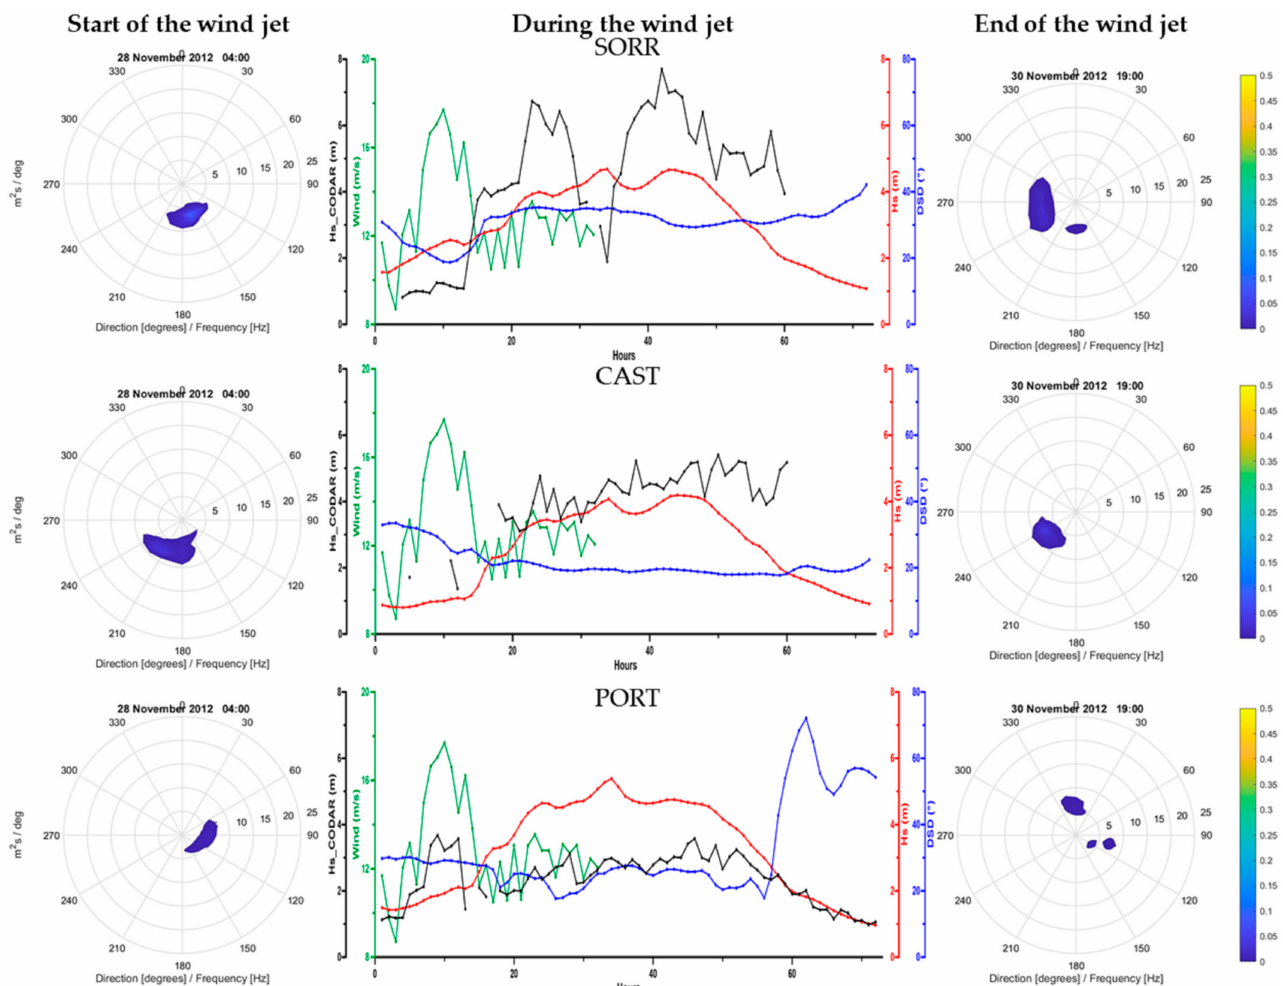
Figure 9. Evolution of storm event (November 2012). Left and right panels show the model spectral energy at the wind jet starts and finishes, respectively. The central panels illustrate the evolution, during the event, of the wind intensity (in green), significant wave height (of the model (in red) and retrieved by the HFr Hs HF (in black)) and directional spreading DSD